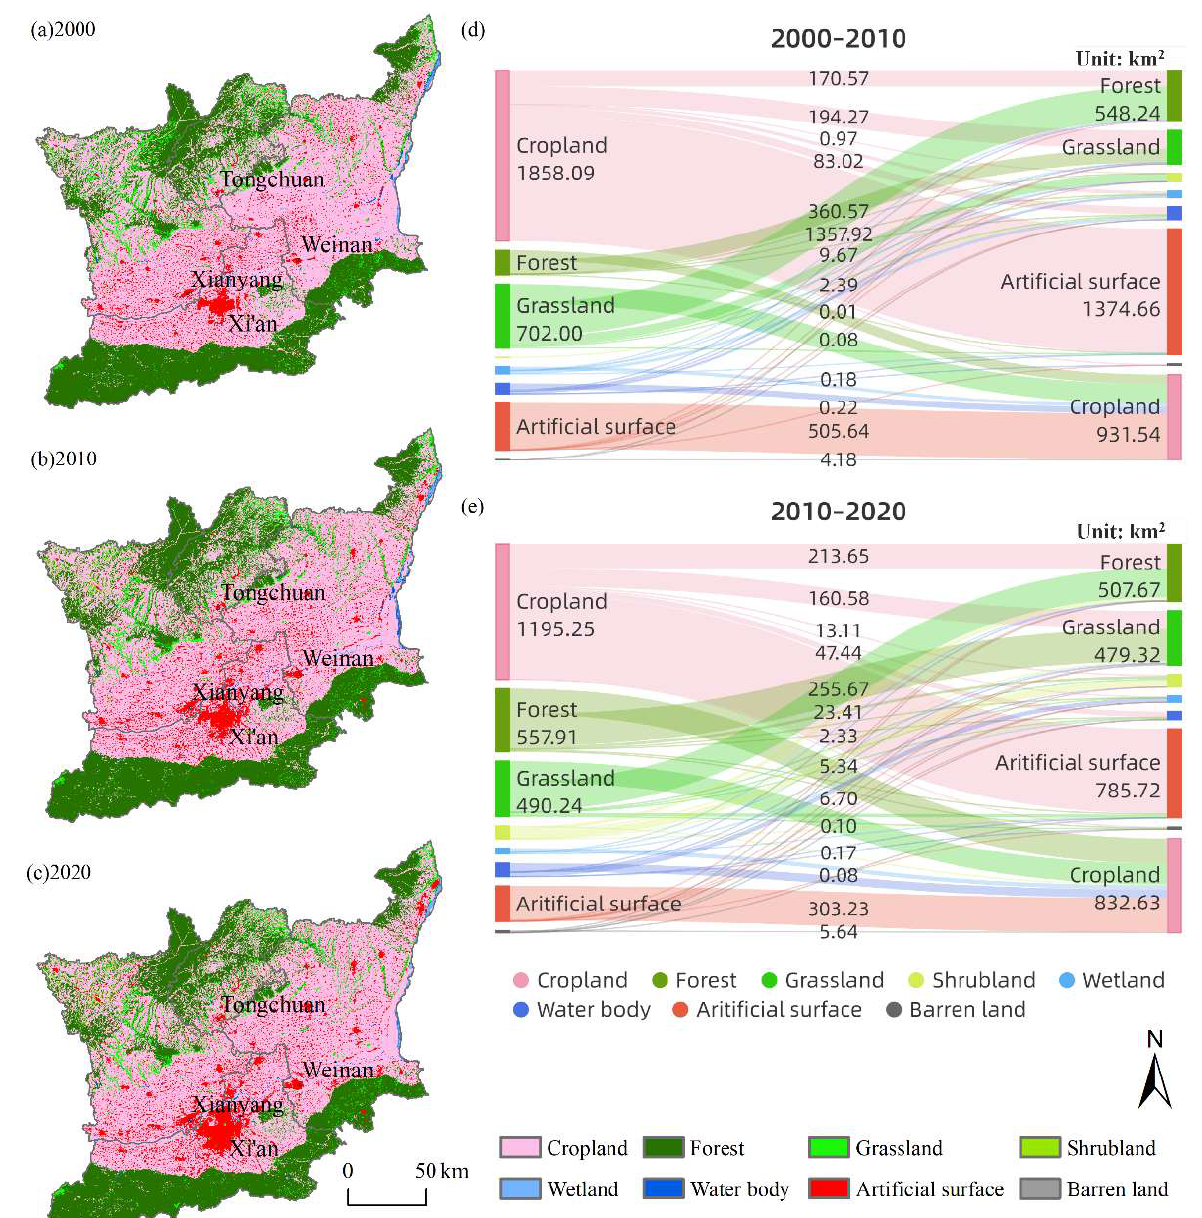
Figure 3. Land-use structure of the XMA in ( a ) 2000, ( b ) 2010, and ( c ) 2020; the flow of conversions in land use in the XMA from 2000 to 2010 ( d ) and from 2010 to 2020 ( e ) (unit: km 2 ). The large spatio-temporal heterogeneity of ES supply was shown in differently sized cities in the XMA (Figures 4–6). ESs were generally in shortage in city centers and rich